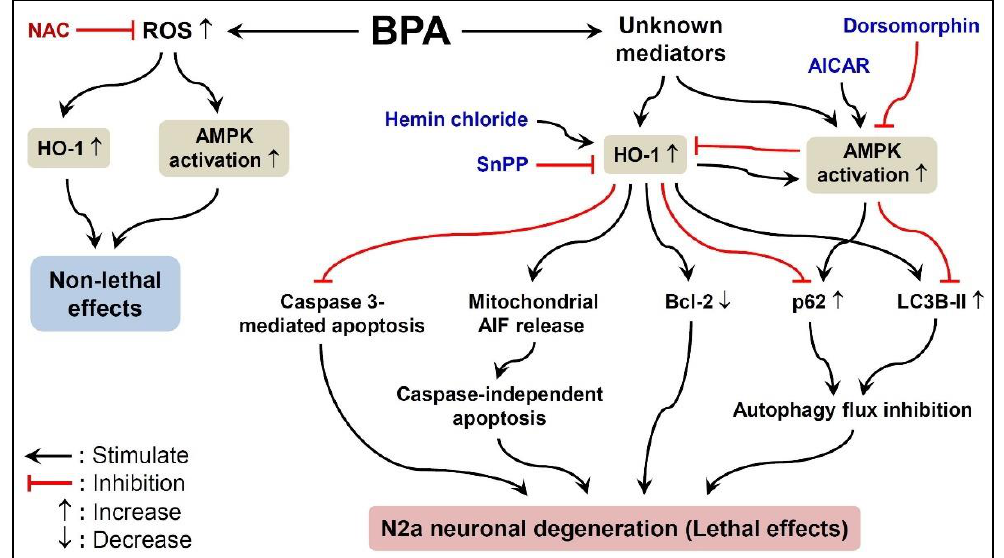
Figure 10. The schematic diagram depicts the degeneration of N2a neurons induced by BPA. BPA, through AMPK activation and HO-1 induction, causes Bcl-2 down-regulation, autophagy defects (characterized by p62 accumulation and LC3B aggregation), and AIF-driven apoptosis, leading to N2a neurotoxicity (e.g., the decline of cell viability and the collapse of neuron-like axon outgrowth). However, caspase-3-mediated apoptosis is not involved.